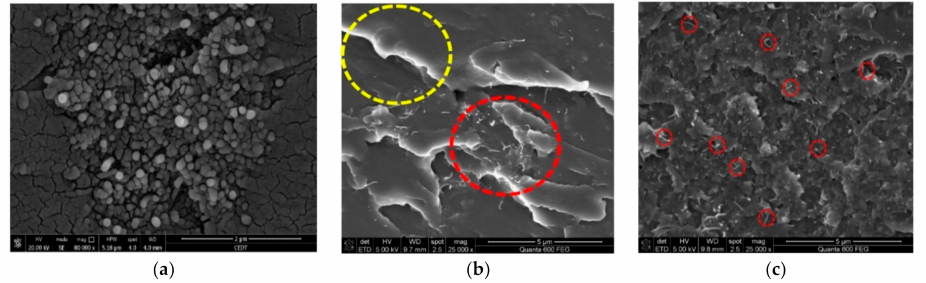
Figure 10. SEM image of ( a ) agglomoration of unmodified MWCNTs (0.5 wt/wt.%), ( b ) nonhomoge- nous dispersion of unmodified MWCNTs in epoxy resin, and ( c ) good dispersion of F-MWCNTs using ultrasonic mixing technique.